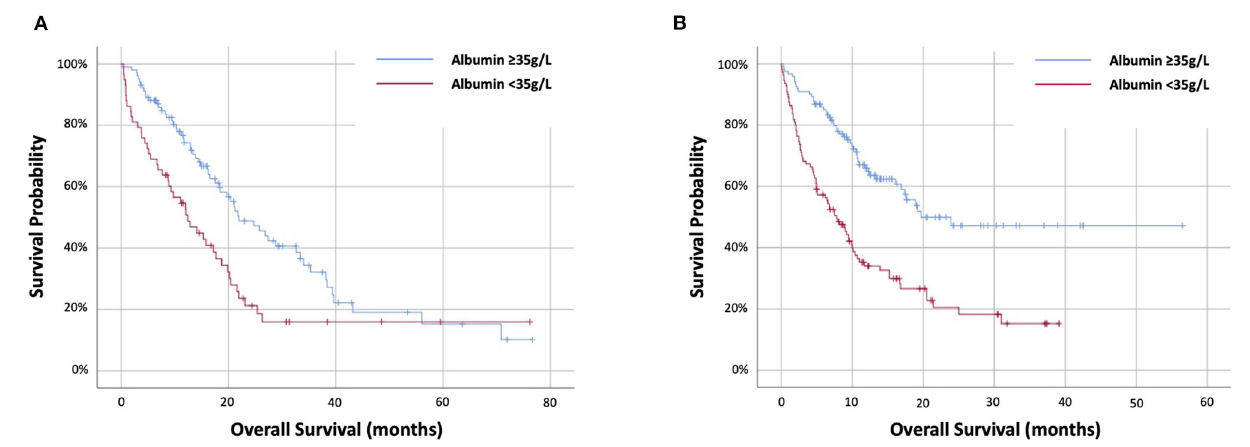
FIGURE 1 | Kaplan–Meier survival curves examining the relationship between pre-treatment albumin and overall survival patients with NSCLC treated with first-line (A) targeted therapy or (B) immunotherapy-based